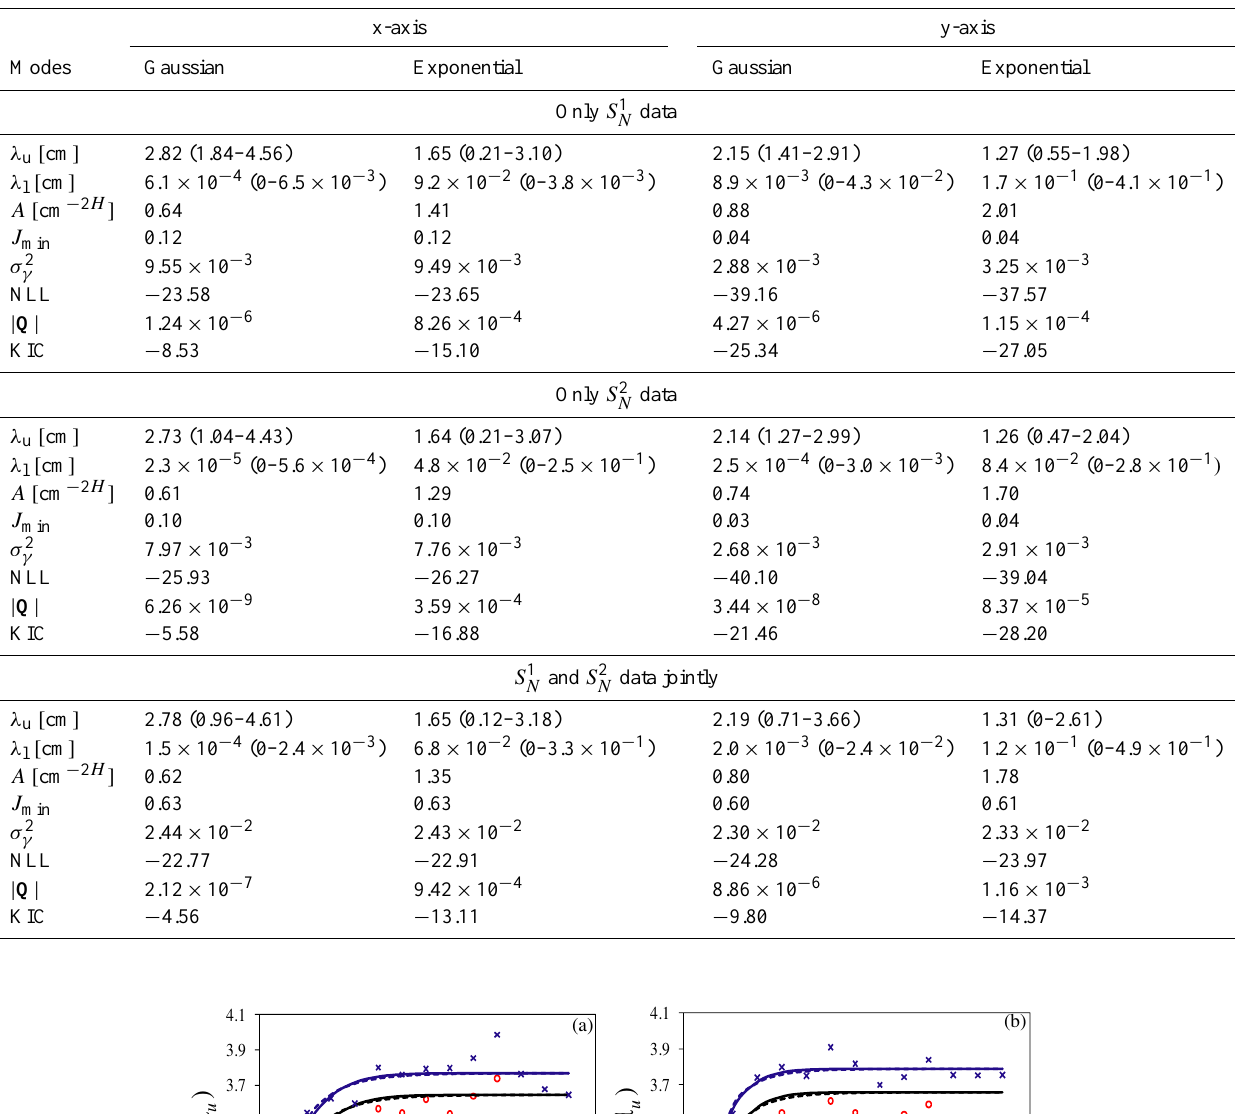
Table 1. Calibration results, main statistics and Model quality criteria. The 95% confidence intervals of the parameter estimates are reported in parenthesis.